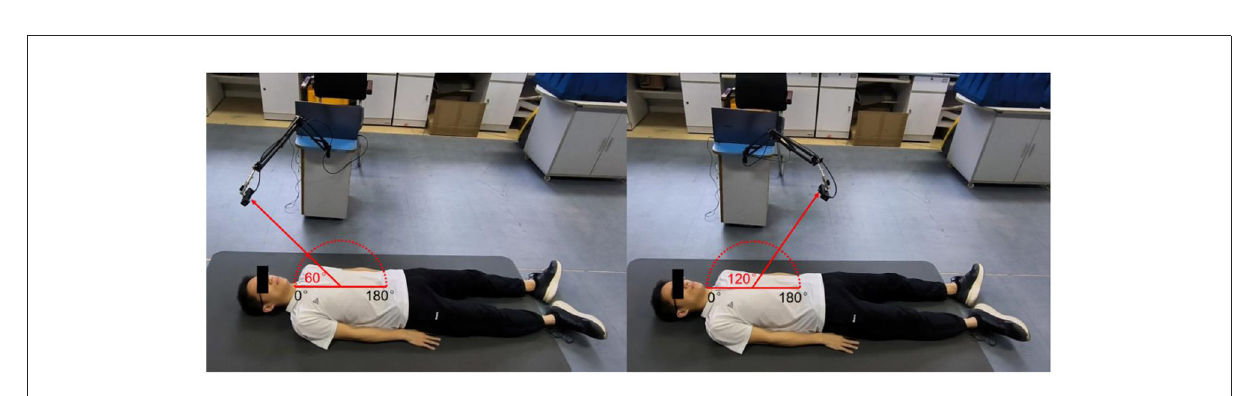
FIGURE11 Scenarios of the along-the-arc